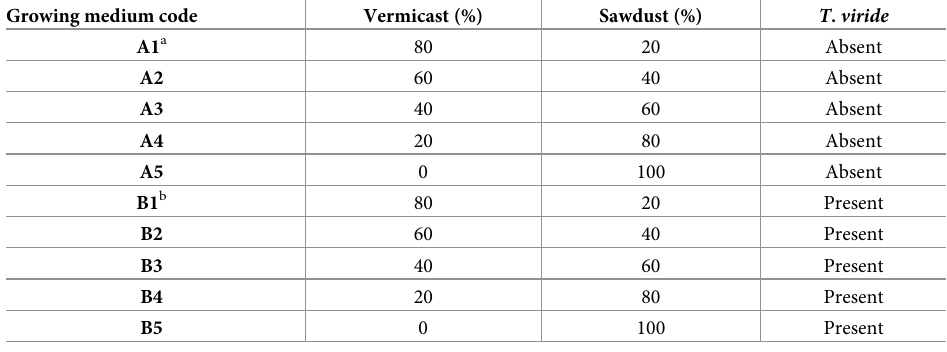
Table 1. Mixed proportions of vermicast, sawdust and Trichoderma viride growing media. Growing medium